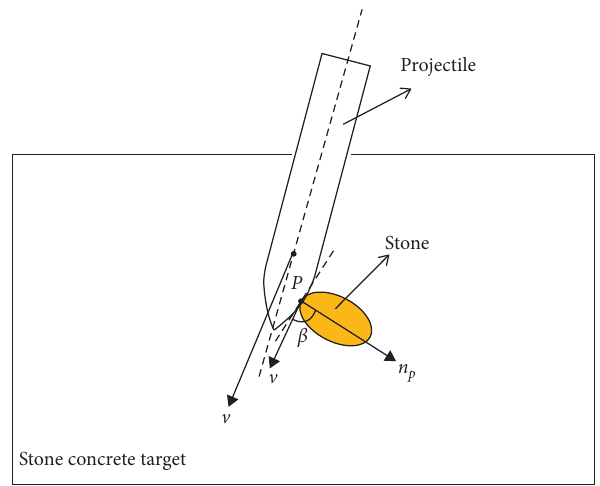
Figure 7: The projectile acts with stone when penetrating into stone